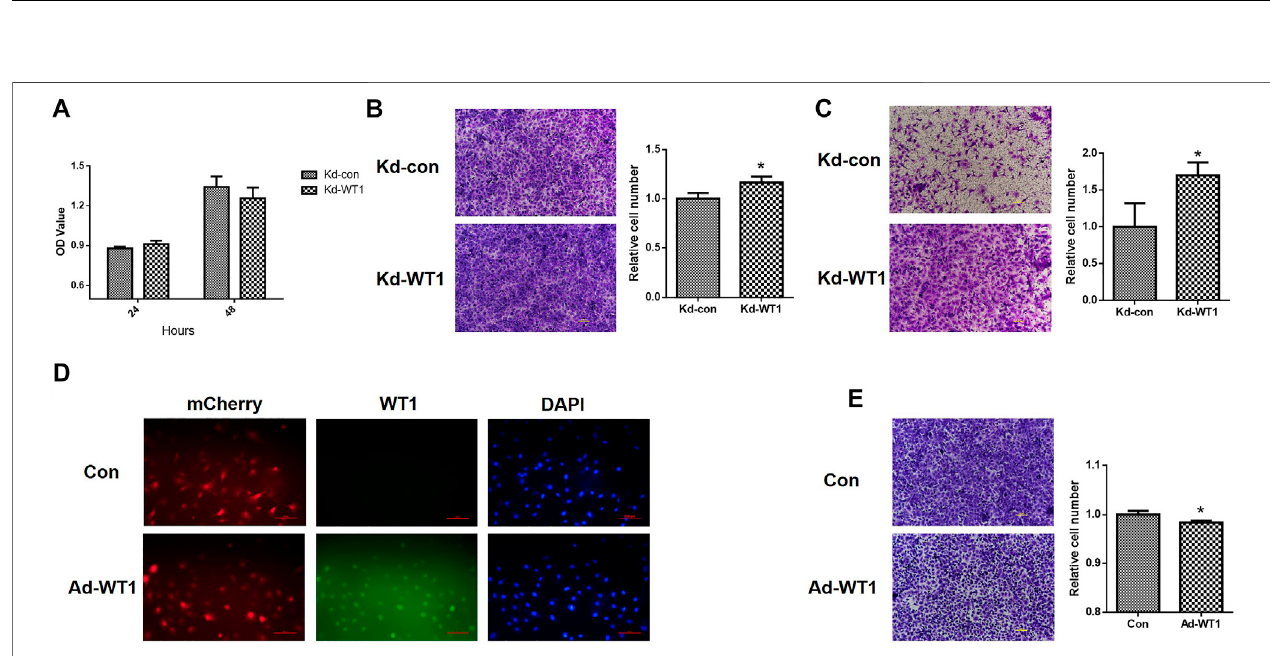
FIGURE 8 | The effect of WT1 on the proliferation, migration and invasion of ovarian cancer cell line SKOV3. (A) CCK assay was used to detect the effect of WT1 down-regulation on cell proliferation. (B) Transwell cell migration assay to detect the effect of WT1 down-regulation on cell migration ability. (C) Transwell cell invasionassaywasusedtodetecttheeffectofWT1down-regulationoncellinvasionability. (D) Infectionef fi ciencyandlocalizationofConandAd-WT1adenoviruses. (E) Transwell cell migration assay to detect the effect of WT1 up-regulation on cell migration ability. * p < 0.05. Kd: knockdown, Ad: addition.